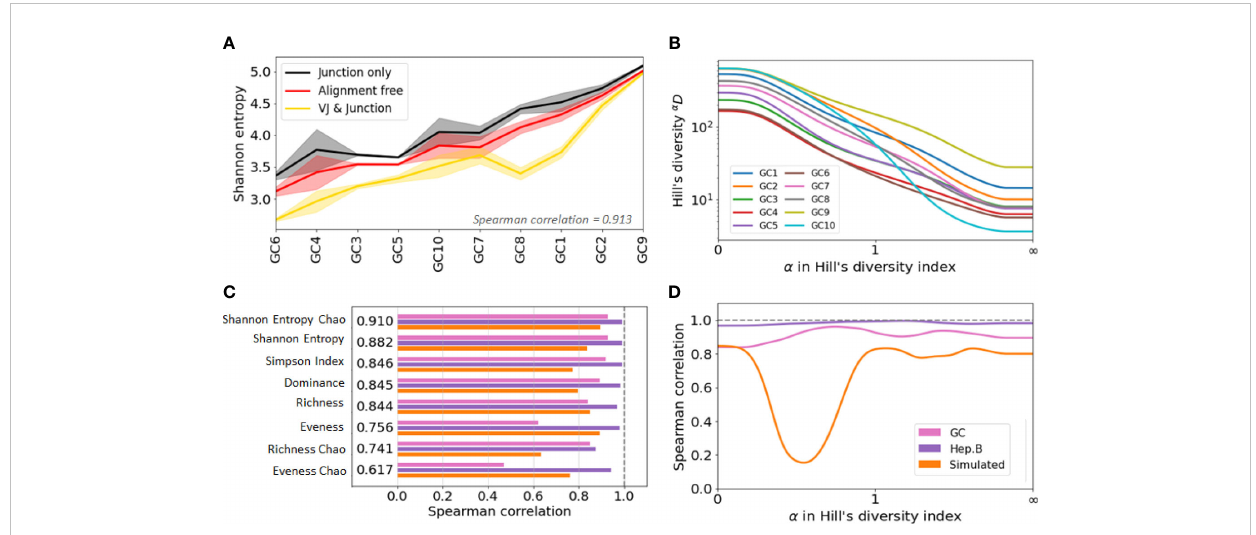
FIGURE 4 Agreement analysis of diversity indices across different clone identi fi cation methods. (A) Shannon entropy diversity index for each GC, listed from least to most diverse. As there are two replicates for each GC, the solid line represent the mean value between the two replicates, and the shaded area highlights the min and max values. (B) Spearman correlation between the diversity indices obtained with the three clonal identi fi cation methods. The computed correlation is shown for the three datasets analyzed in our study. The fi gure shows the average correlation across the three datasets. (C) Hill ’ s Diversity pro fi les of each GC (averaged over the two replicated) with clones obtained from the alignment free method (the x-axis has been transformed with an exponential tangent function for visual clarity). (D) Mean Spearman correlation between the diversity indices obtained with the three clonal identi fi cation